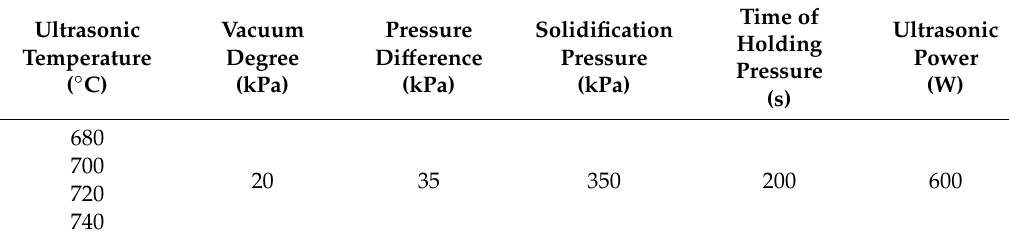
Table 2. Technical parameters of vacuum counter-pressure casting with ultrasonic treatment (UST).